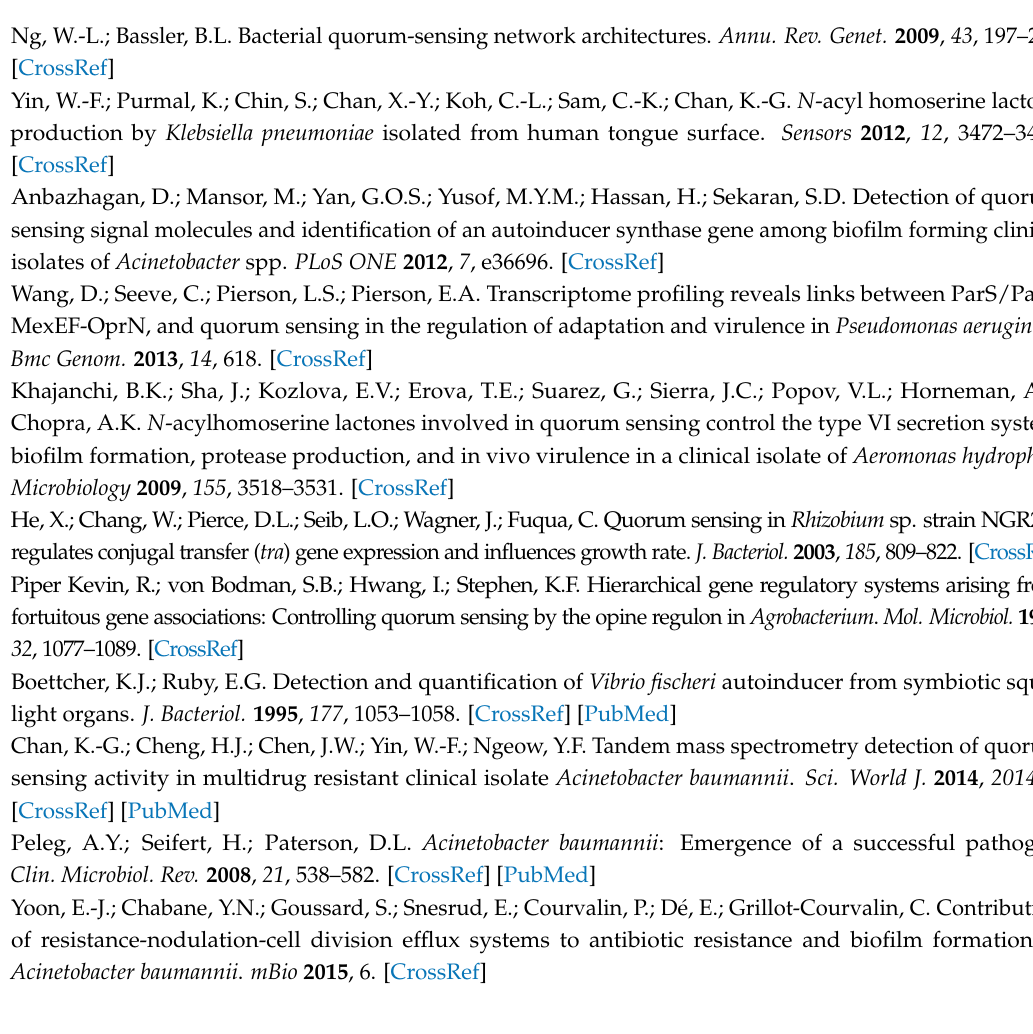
Table S1: List of Genes with differential